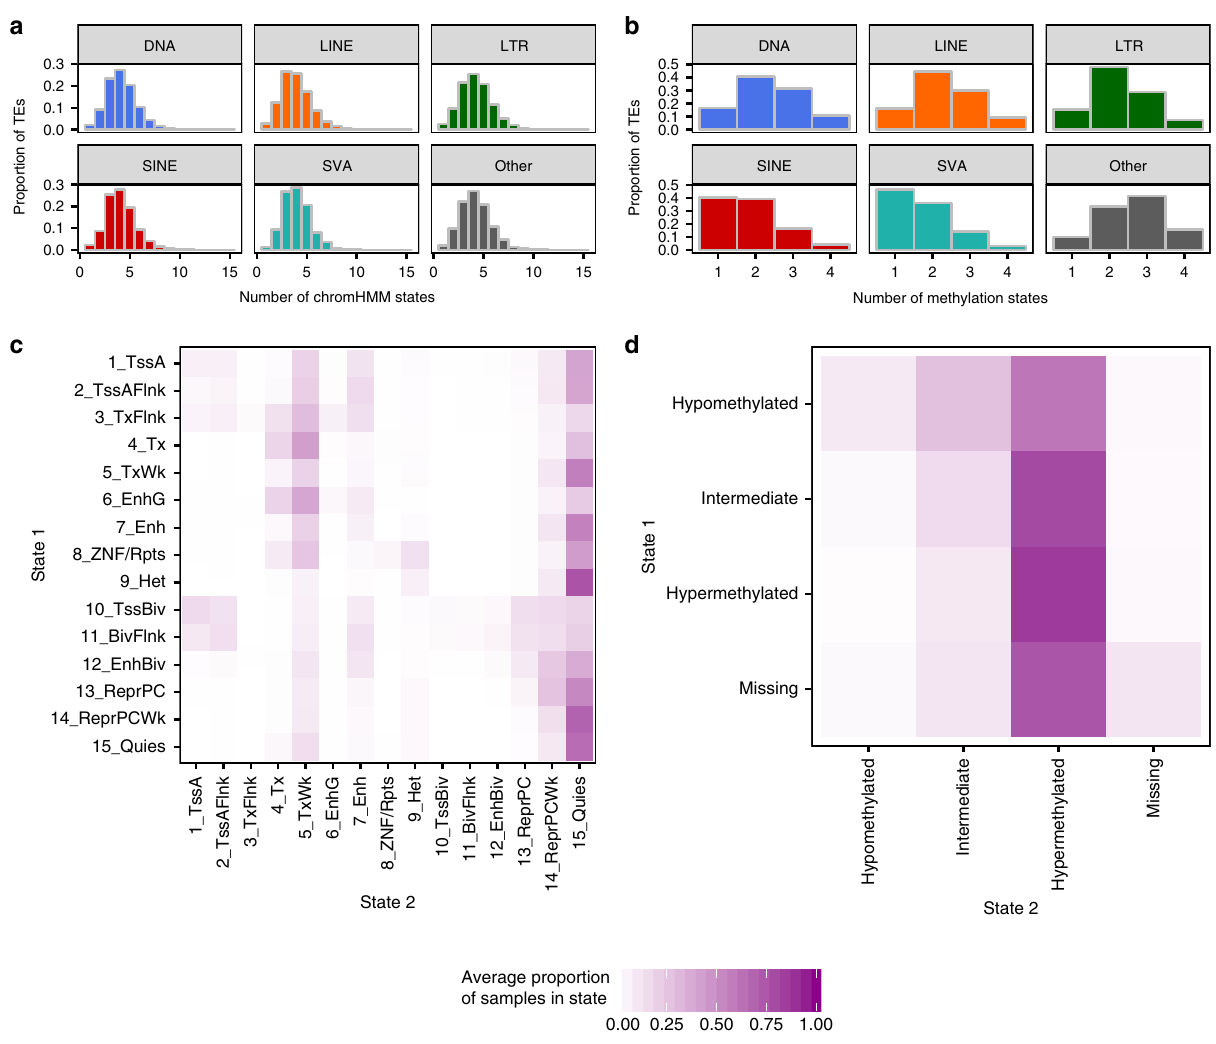
Fig. 3 Epigenetic state dynamics of TEs. a For all individual TEs in each class, the total number of chromHMM states the TE is annotated with across all epigenomes (DNA n = 456,948 TEs, LINE n = 1,480,369, LTR n = 708,210, SINE n = 1,769,839, SVA n = 3,608, Other n = 11,814). b For all individual TEs in each class, the total number of methylation states the TE is annotated with across all epigenomes (TEs overlapping CpGs only: DNA n = 275,140 TEs, LINE n = 952,459, LTR n = 532,571, SINE n = 1,430,171, SVA n = 3,519, Other n = 6,568). a, b Histograms are colored by class (facet). c For TEs in chromHMM State 1 in at least one Roadmap epigenome (see Fig. 2a, red dots), the average proportion of epigenomes in which they are annotated with chromHMM State 2 (represented by color scale below c , d , 0 to 100% of epigenomes). d For TEs in methylation State 1 in at least one Roadmap epigenome (see Fig. 2a, red dots), the average proportion of epigenomes in which they are annotated with methylation State 2 (represented by color scale below c , d , 0 to 100% of